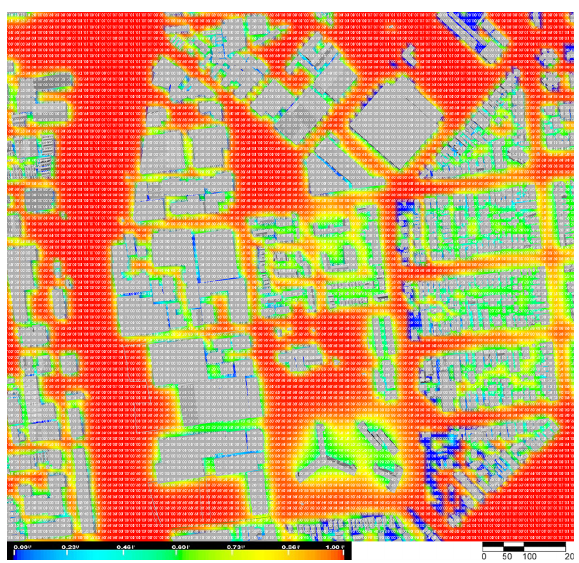
Figure 11. This figure shows Arden-Macaulay, an inner suburb of Melbourne, Australia, SVF calculated at 10m intervals.